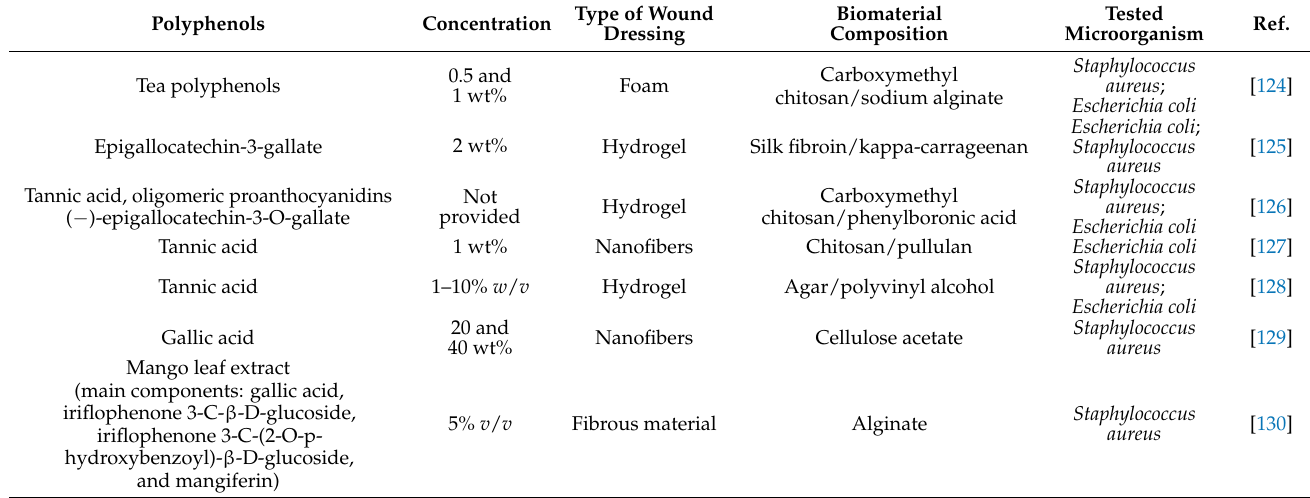
Table 8. Antibacterial polyphenol-loaded biomaterials for wound healing